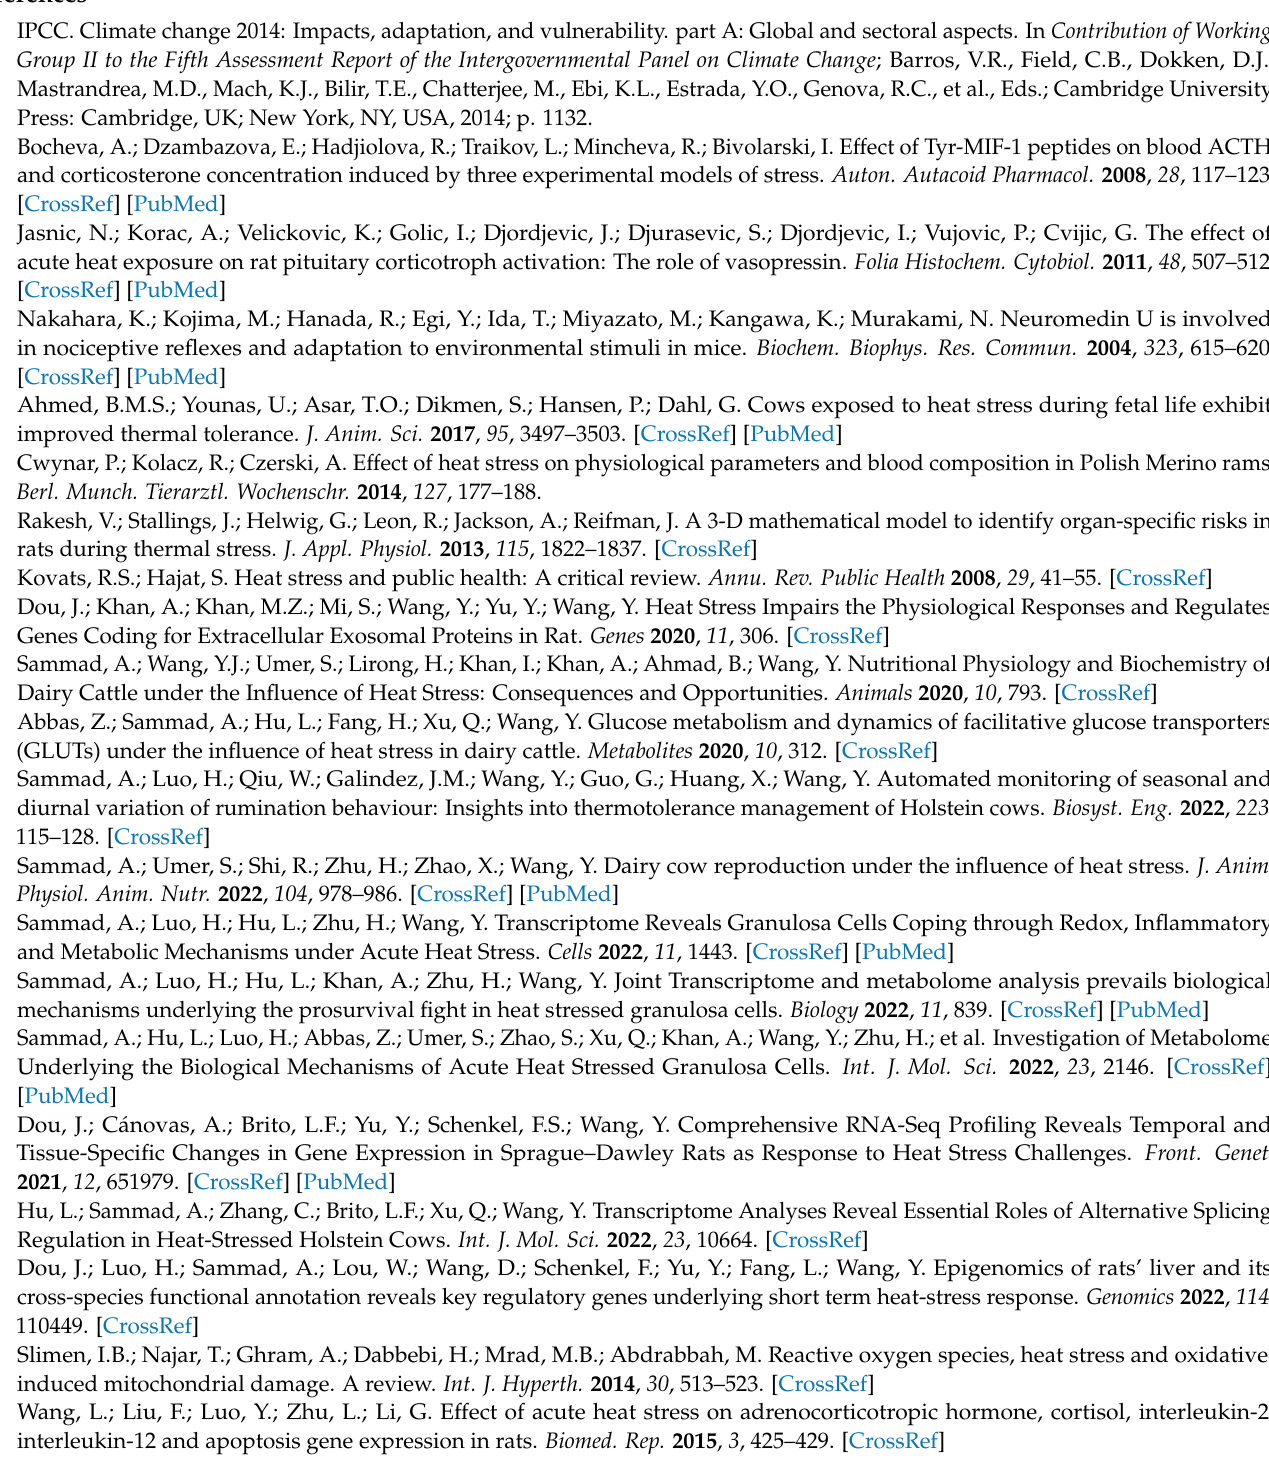
Data Availability Statement: The RNA-Sequencing datasets of the CT and H120 groups (blood, liver, and adrenal glands) and datasets of the H30 and H60 groups (liver and adrenal glands) used in this work are available in the Sequence Read Archive (SRA) at the National Center for Biotechnology Information (NCBI) with BioProject IDs PRJNA589869 and PRJNA690189, respectively. Conflicts of Interest: The authors declare that the research was conducted in the absence of any commercial or financial relationship that could be constructed as a potential conflict of